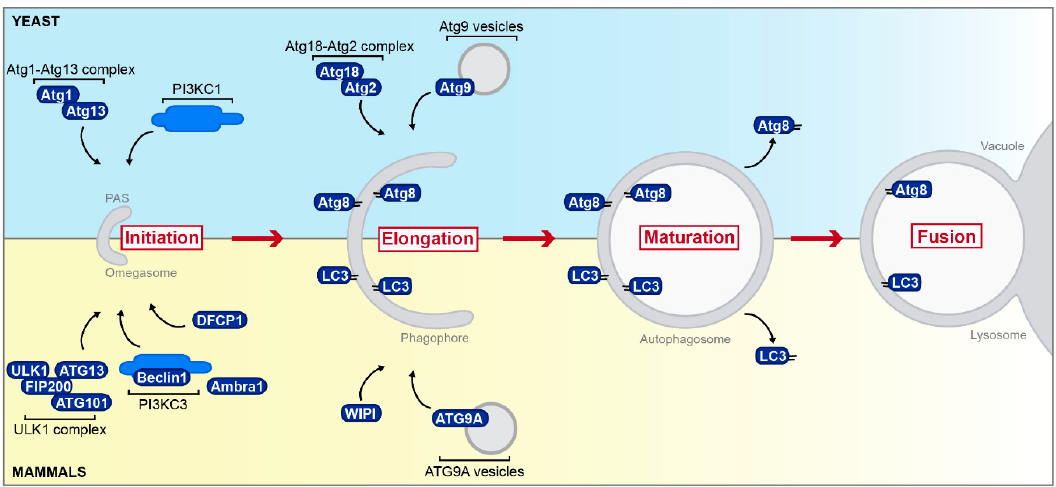
Figure 3. Simplified overview of autophagy in yeast and mammals. Selected aspects of the autophagic process from initiation at the phagophore assembly site (PAS) in yeast (blue) or the omegasome in mammals (yellow) to fusion with the vacuole/lysosome including proteins mentioned in later sections are depicted. Please see main text for further details. PAS = phagophore assembly site.